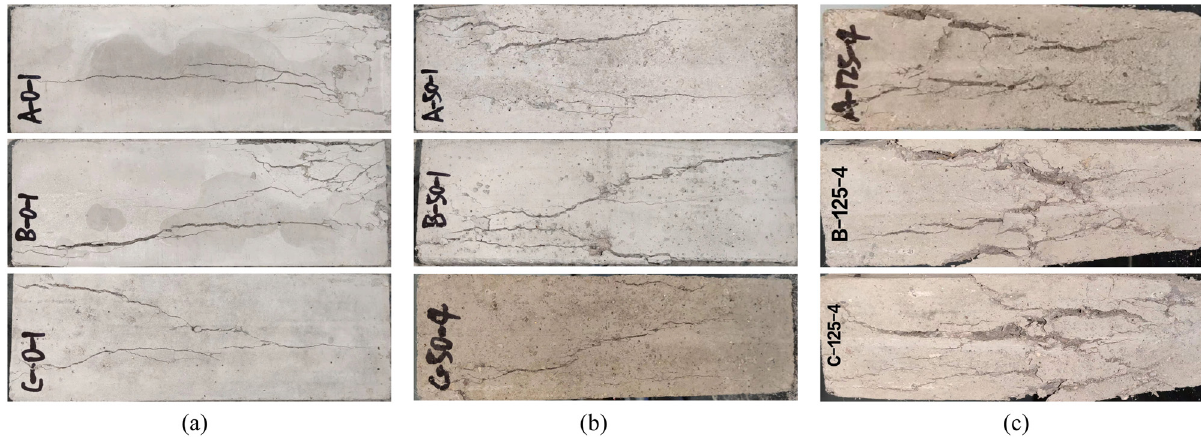
Figure 11: Concrete failure form before and after freezing and thawing: ( a ) 0 time, ( b ) 50 time, and ( c ) 125